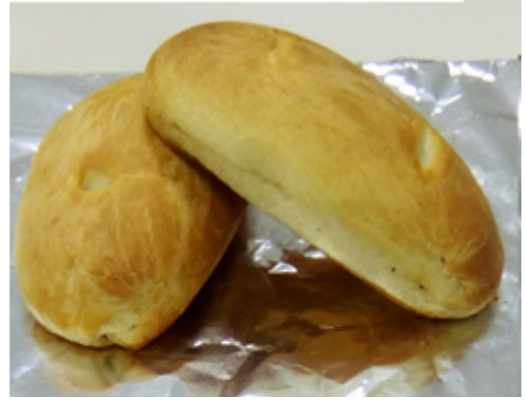
Figure 8: The innovative brioche type product